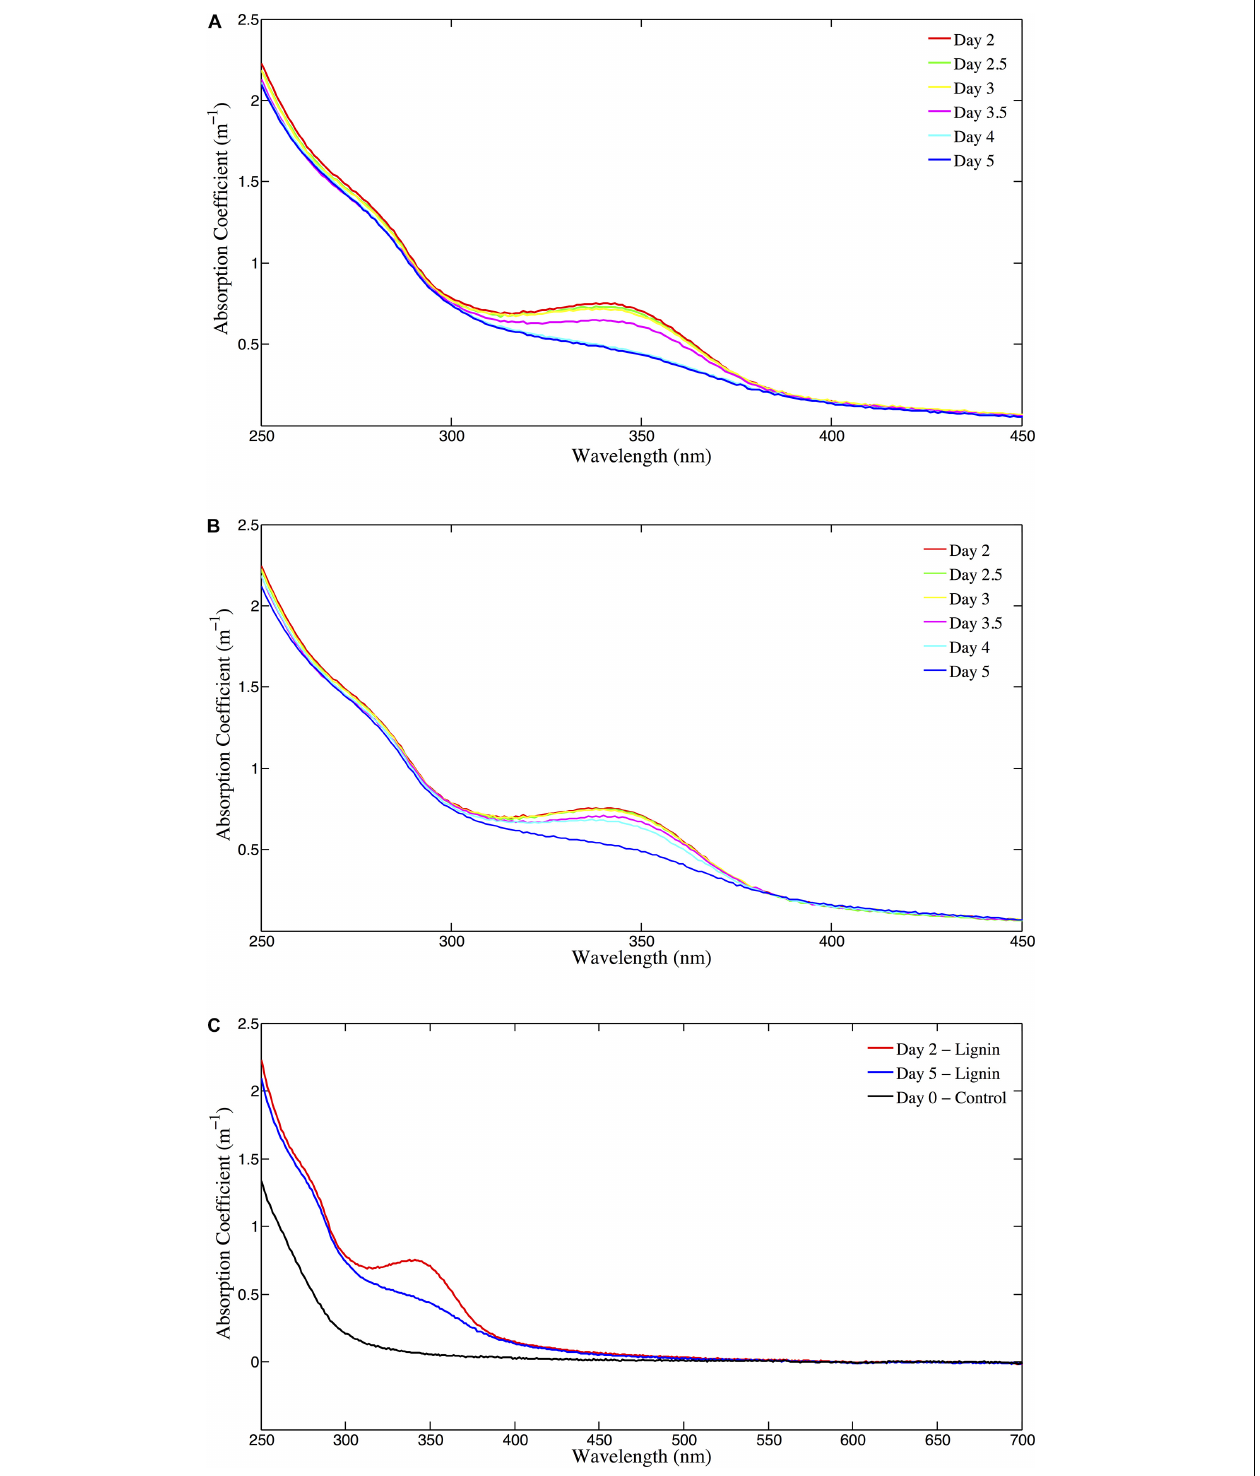
FIGURE 3 | (A) CDOM absorption coefficient (m – 1 ) for the Lignin treatment [250–450 nm, for days 2–5 ( T 4 – T 9 )]. (B) CDOM absorption coefficient (m – 1 ) for the LNP treatment [250–450 nm, for days 2–5 ( T 4 – T 9 )]. (C) CDOM long-wavelength absorbance (250–700 nm; m – 1 ) for Lignin on days 2 and 5 ( T 4 and T 9 ) and Control T 0 (day